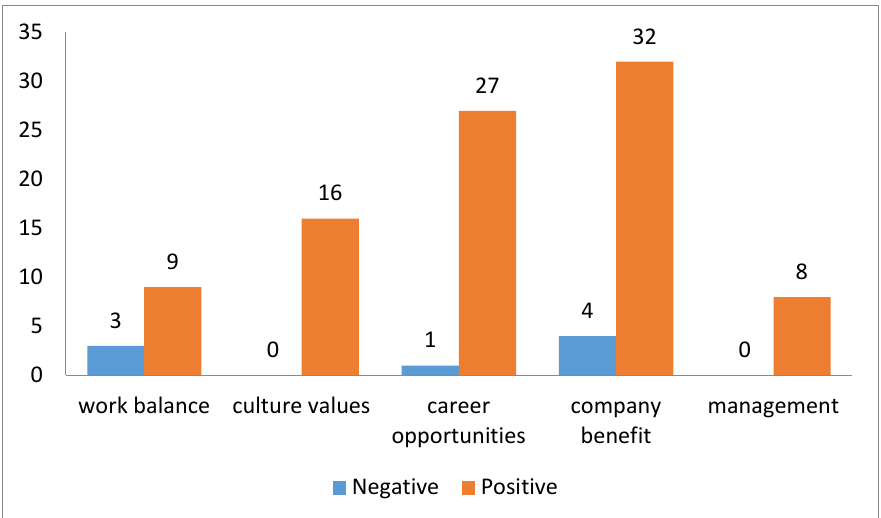
Fig. 7 Aspect score of each aspect from Google company’s